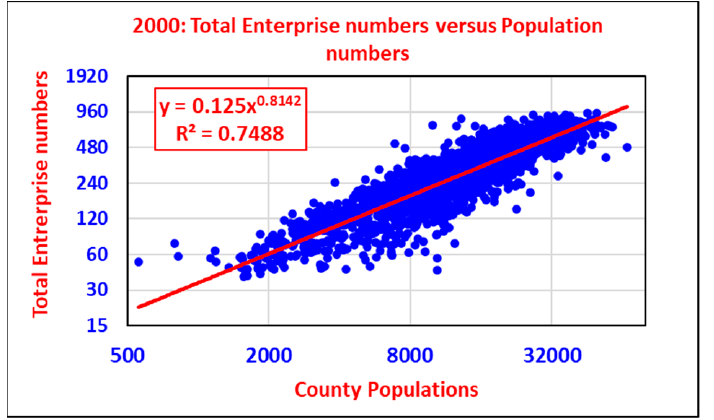
Figure 2. The power law relationship between county population numbers and total enterprise numbers in 2000. Table 2. Power law relationships between the population numbers and total entrepreneurship of 1785 U.S. counties in 2000, 2007, and 2010.